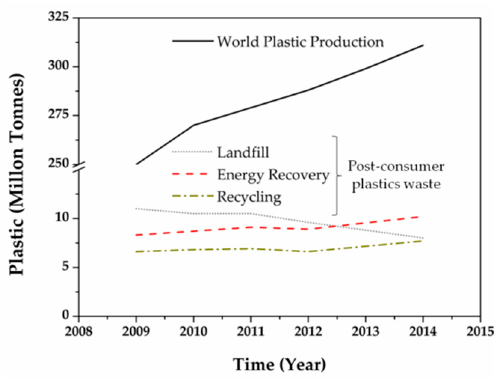
Figure 1. Progress of world plastic production and annual average of plastics post-consumer waste generation (data obtained from Plastics Europe [10]).